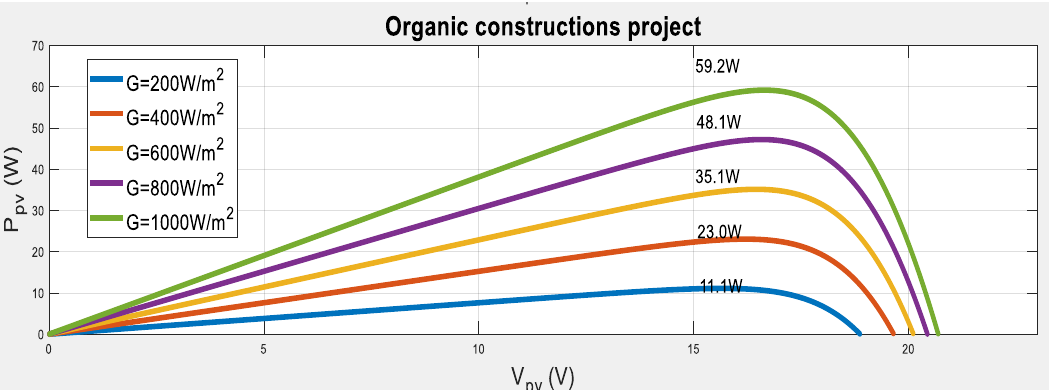
Figure 13. Voltage photovoltaic V pv -Current photovoltaic I pv curves at different values of irradiance- W/m 2 .